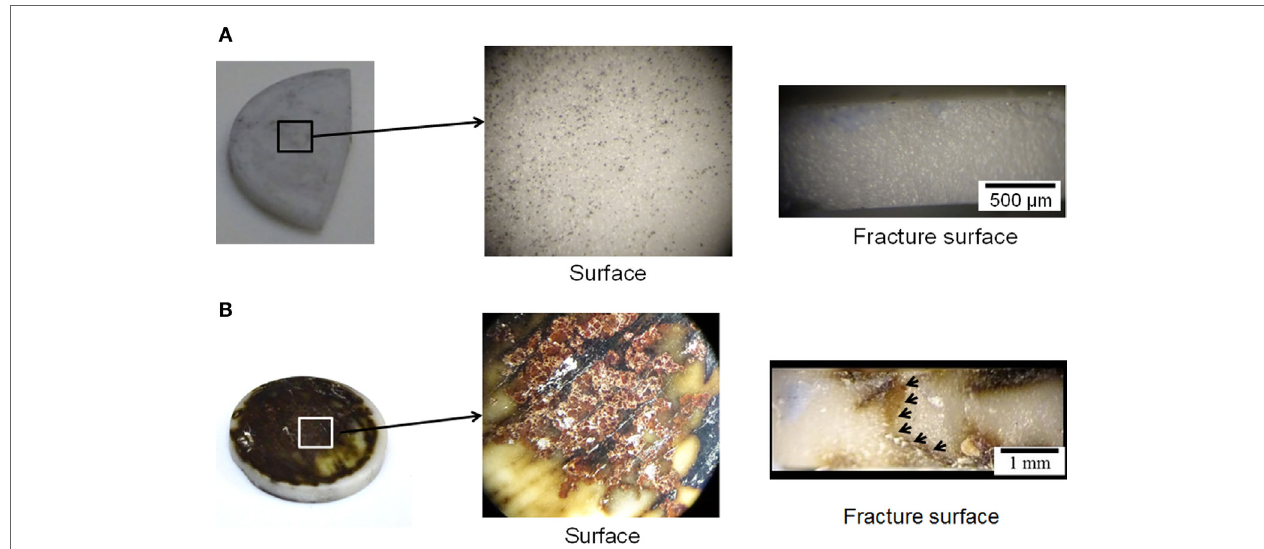
FigUre 5 | The optical images of the pellet faces and fracture surfaces for the Dc cycled hot-pressed (a) li 6.5 la 3 Zr 1.5 Ta 0.5 O 12 and (B)